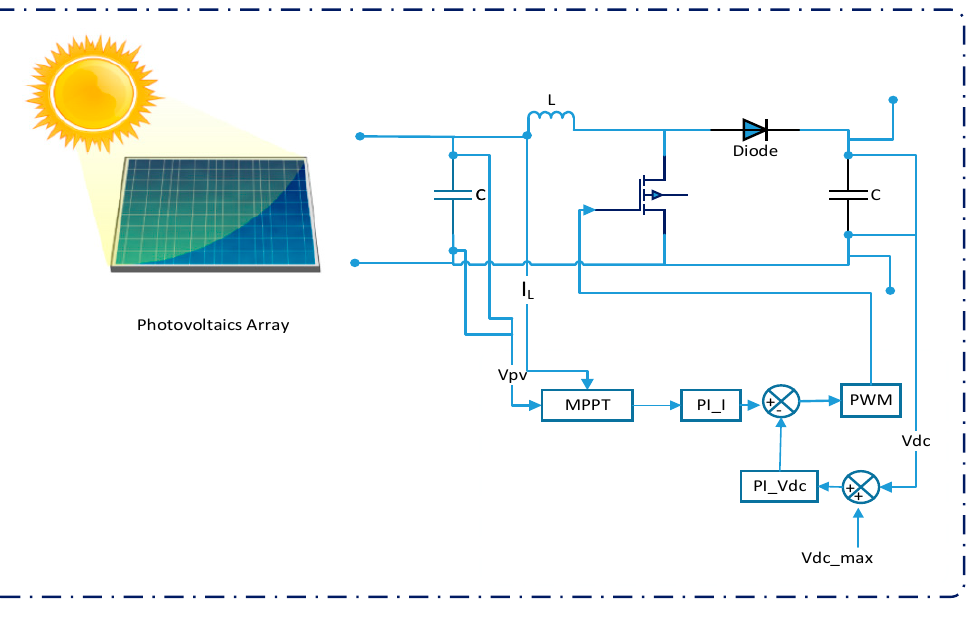
Figure 14. MPPT control of boost converter.